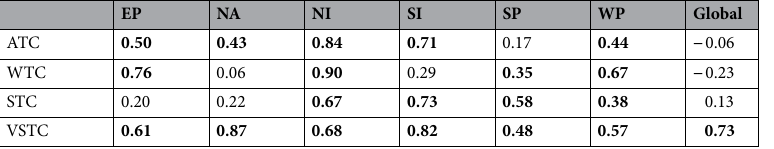
V land and annual frequency of landfalling TCs. Bolded numbers indicate Table 3. Correlation coefficient of (cid:31) statistically significant trends at α = 0.05.